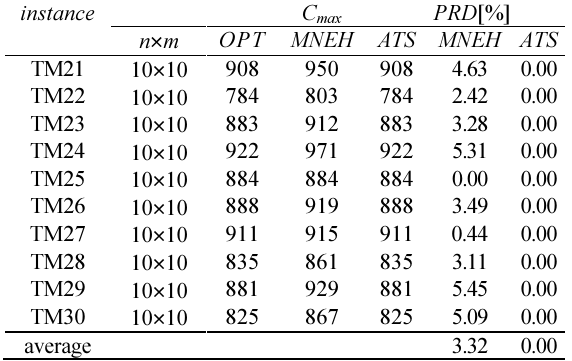
Table 3. The cost function value for the optimal solution and solutions obtained by the MNEH and the tabu search algorithms